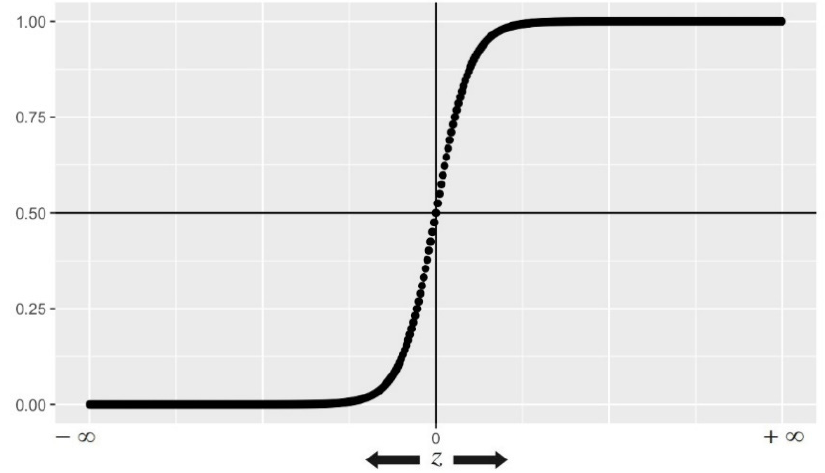
Figure 16. Representation of the Logistic Function (The values of this function have been plotted as 𝑧 varies from −∞ to + ∞ ).